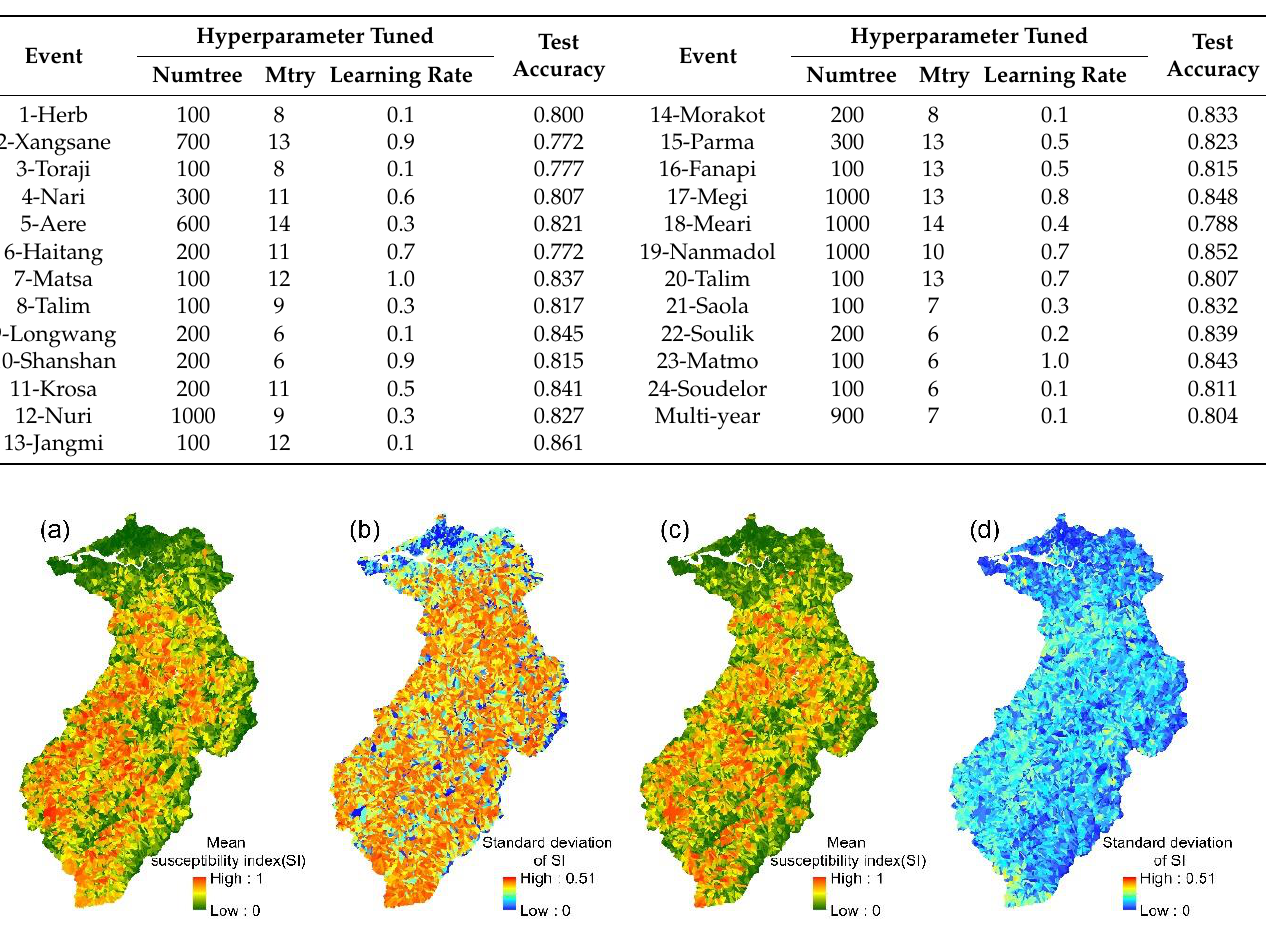
Table 8. The tuned hyperparameters and model performances for GBDT models.